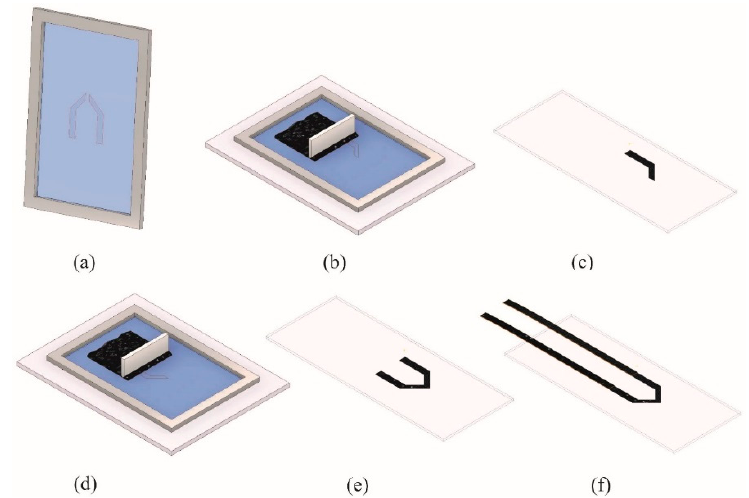
Figure 1. Fabrication process of a thermocouple. ( a ) Printing screen with the features to be printed; ( b ) printing of the first carbon-black ink; ( c ) the first carbon-black structure on glass substrate; ( d ) printing of the second carbon-black ink; ( e ) finished printed thermocouple; ( f ) thermocouple with carbon-black-coated Kapton strips as electrical connections.